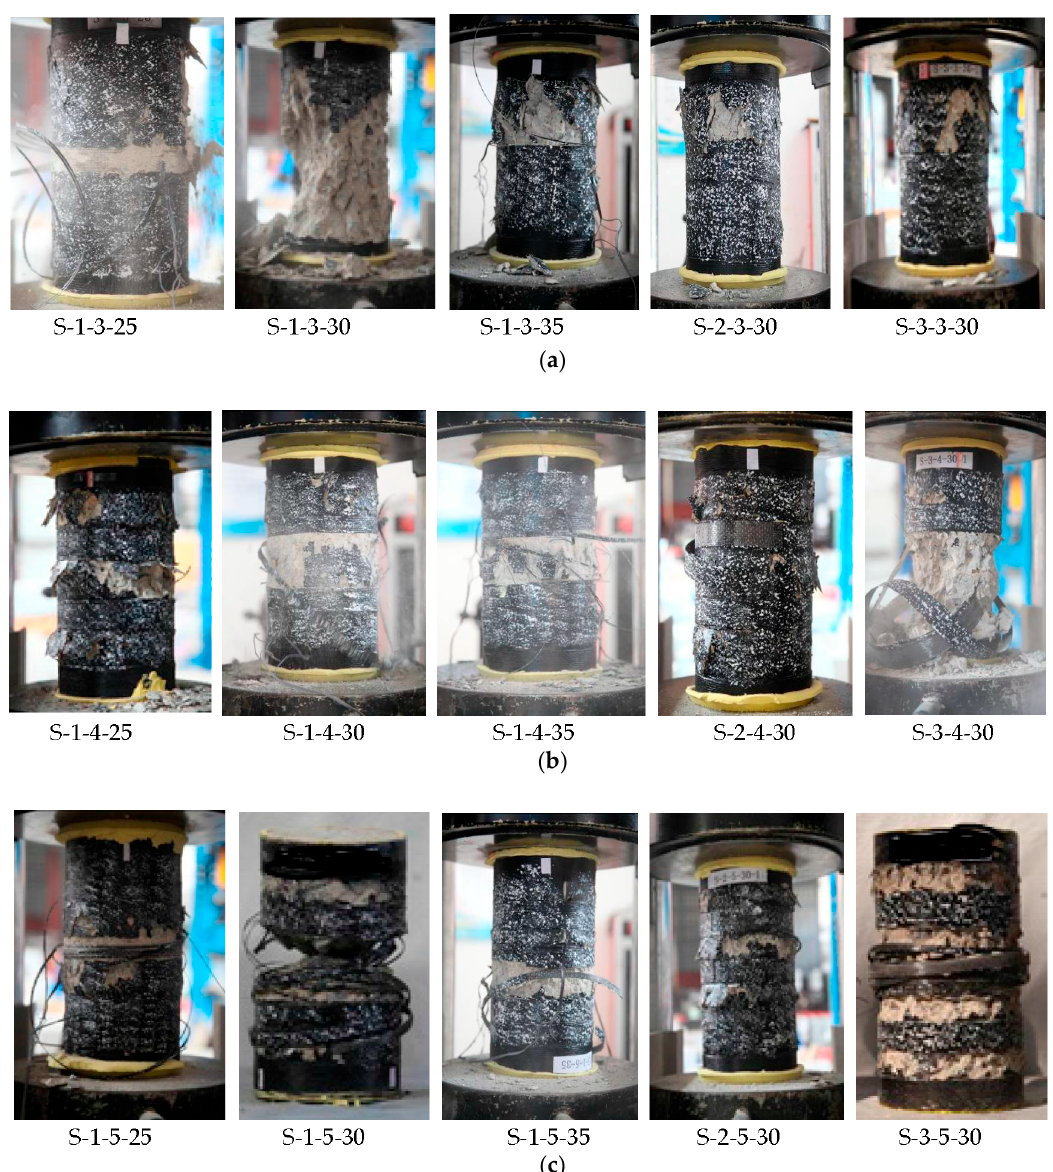
Figure 8. Failure modes. ( a ) Specimens wrapped with three FRP strips; ( b ) Specimens wrapped with four FRP strips; ( c ) Specimens wrapped with five FRP strips.